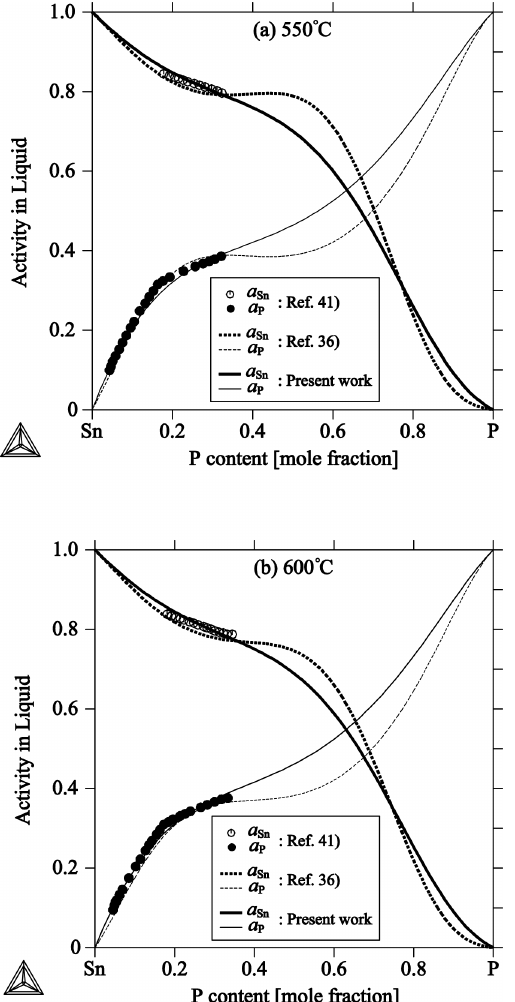
Figure 4. Calculated specific heats of (a) Sn 4 P 3 and (b) SnP 3 . Figure 5.